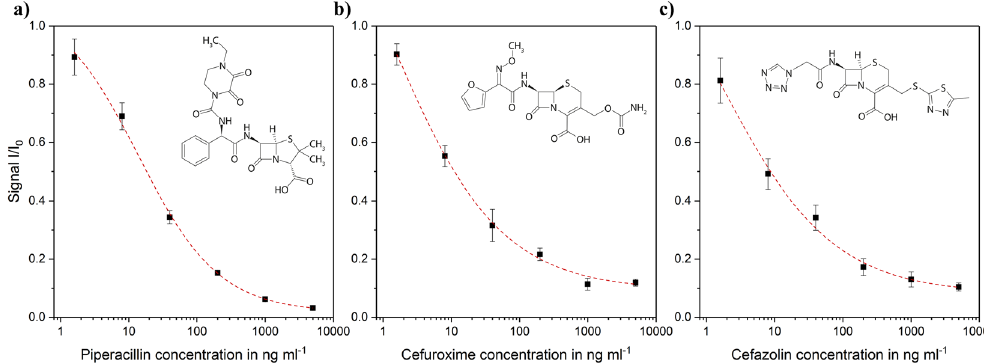
Figure 2. Calibration curves (n = 4) of ( a ) piperacillin, ( b ) cefuroxime and ( c ) cefazolin in human serum diluted 1:1000 in PBS for stopflow times of 2 min. The calibration points are fitted with a 4-parametric logistic curve, resulting in an inter-assay coefficient of variation of less than 20% and LODs of 2.07 ng ml − 1 , 4.88 ng ml − 1 and 5.71 ng ml − 1 for piperacillin, cefuroxime and cefazolin, respectively. I/I0 represents the current peak obtained for the measured sample (I) normalized to the current peak for a sample free of antibiotic